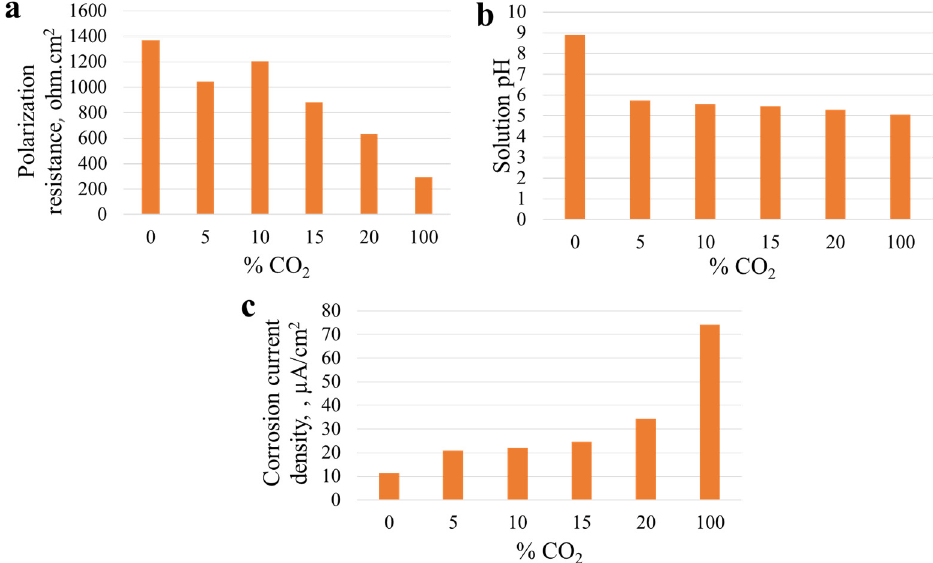
Figure 7. Effect of increasing CO 2 content on the measured electrochemical parameters; ( a ) polarization resistance; ( b ) solution pH; ( c ) corrosion current density. Data from [52].